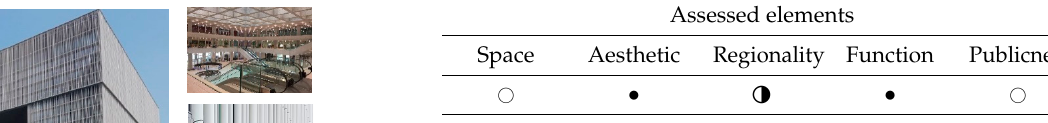
Table 5. Decorative facades: Amorepacific headquarters (David Chipperfield/Haeahn Architecture 2017).